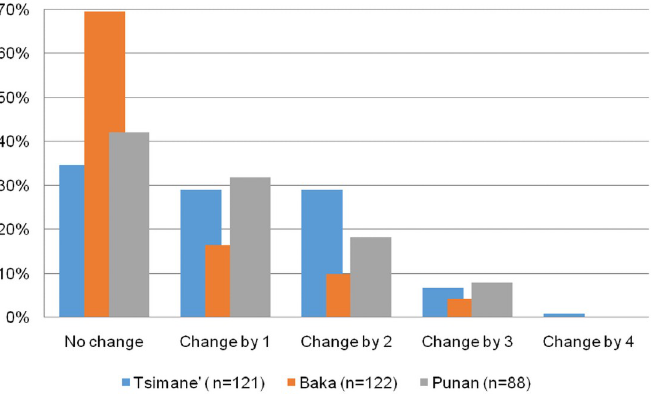
Fig 2. Individual variation in life satisfaction score, percentage by